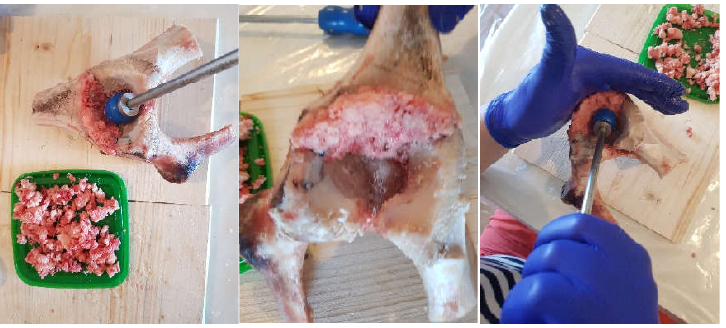
Figure 9. Removing marked areas and positioning the polyethylene cup.